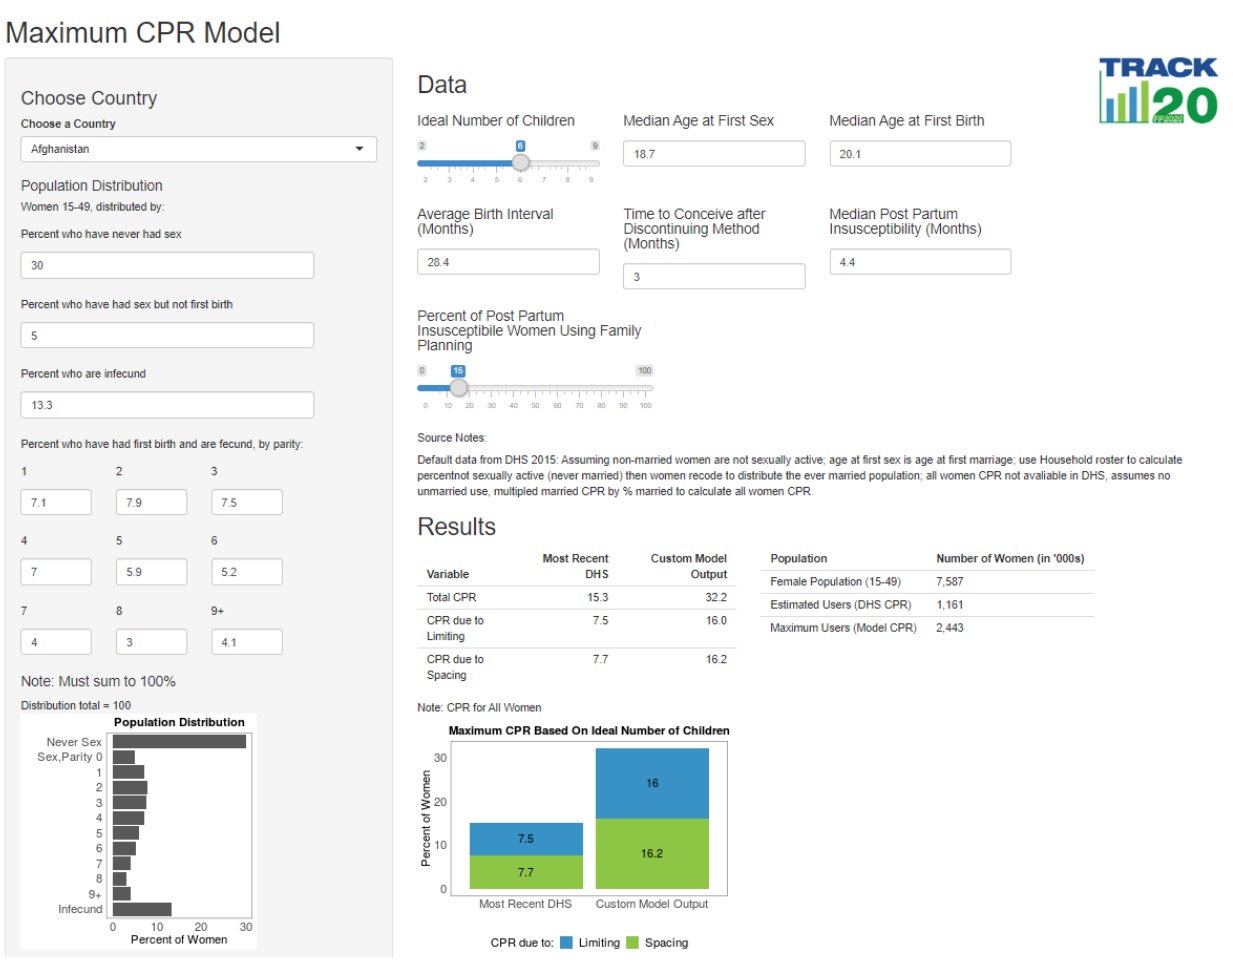
Figure 1. The online maximum CPR Model. An interactive version of this plot can be viewed here: